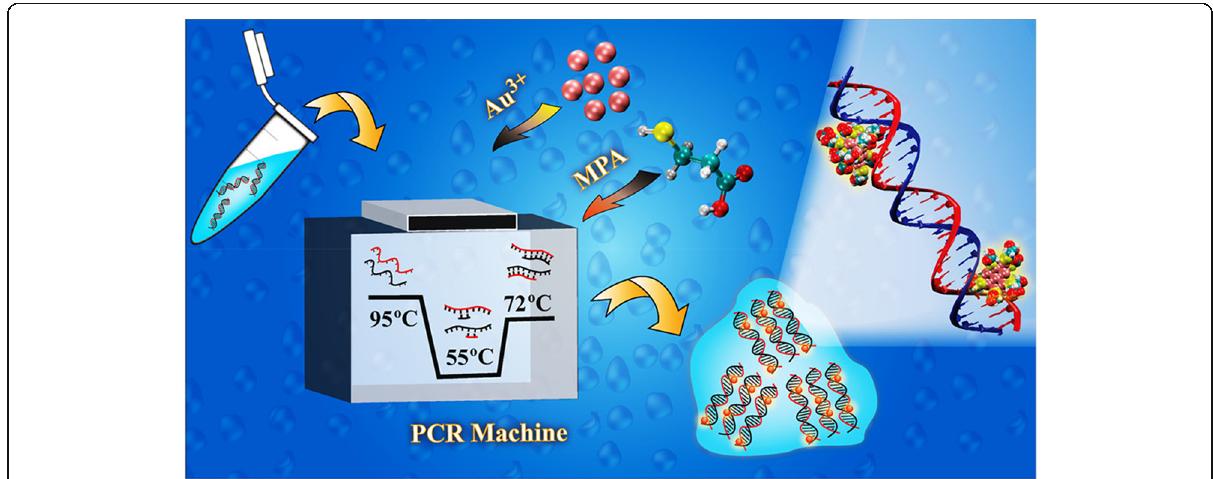
Fig. 9 The method for the synthesis of luminescent AuNCs by emulating the PCR condition [95]